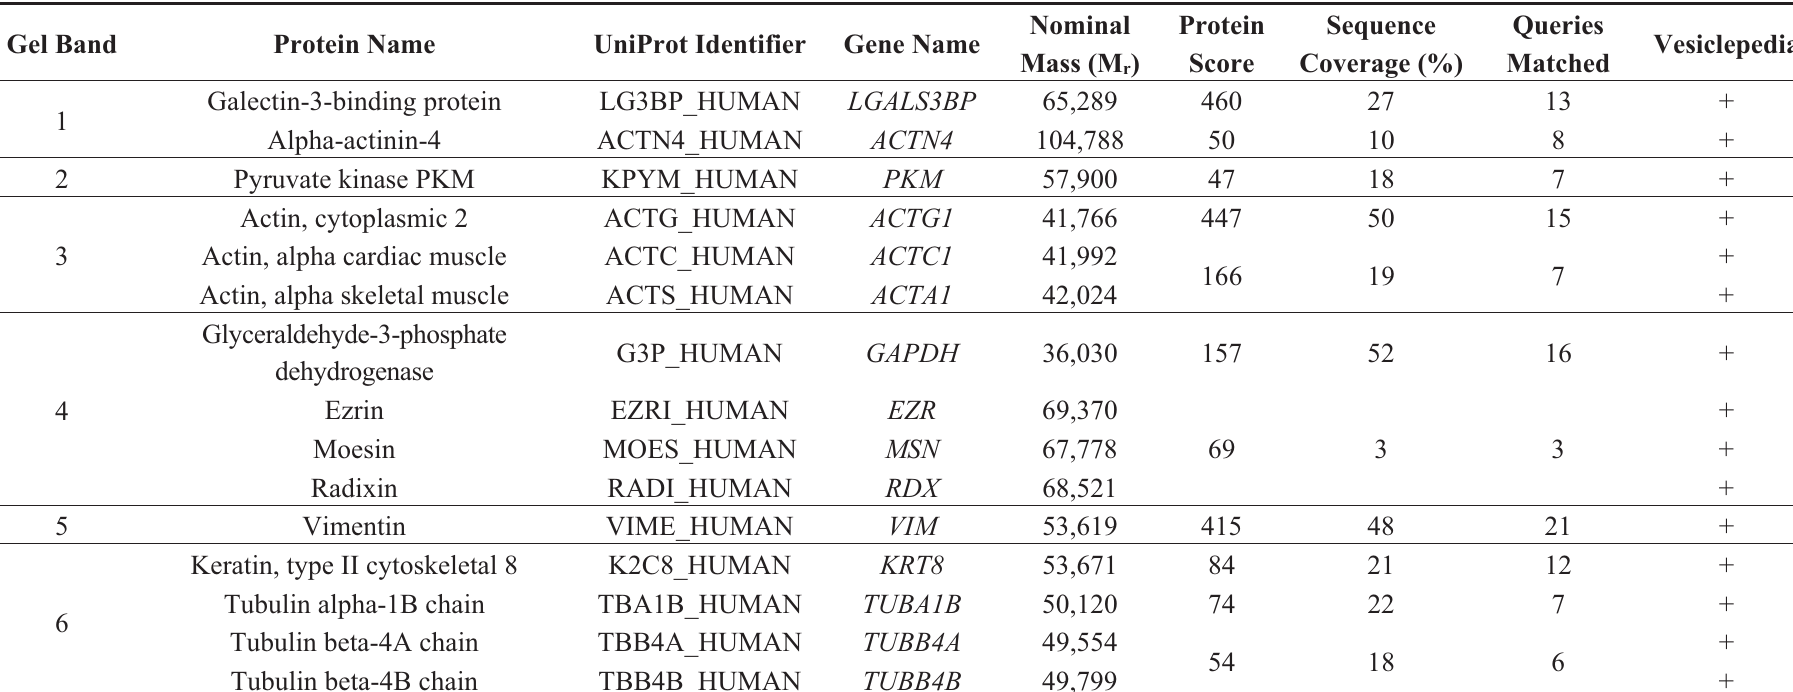
Table 1. List of proteins identified in EVs and MBs from OVMz cells using MALDI-TOF/TOF after SDS-PAGE separation using MALDI-TOF/TOF. Bands were excised from the gel shown in Figure